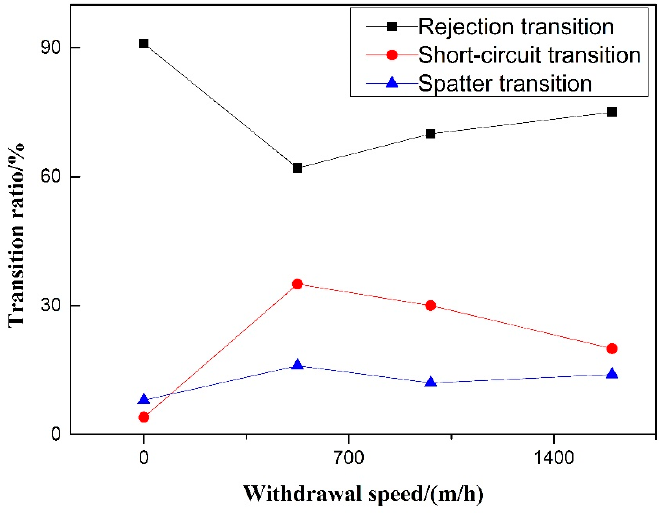
Figure 11. Effect of withdrawal speed on transition ratio. Figure 11. E ff ect of withdrawal speed on transition ratio.